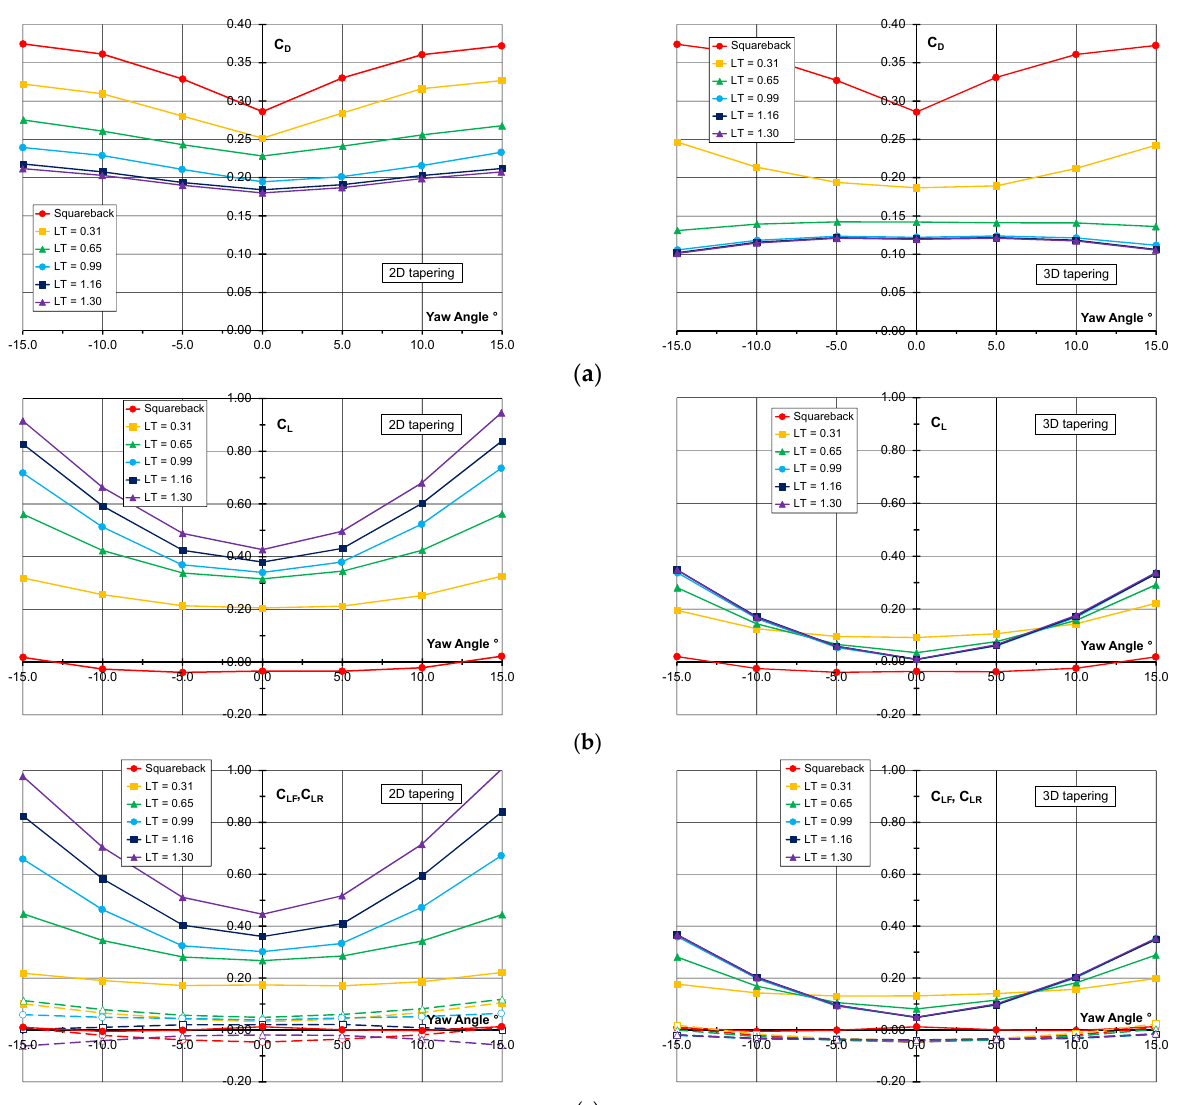
Figure 3. ( a ). Drag coefficient. (Left) 2D tapered body, (Right) 3D tapered body. ( b ). Lift coefficient. (Left) 2D tapered body, (Right) 3D tapered body. ( c ). Front/rear axle lift coefficients. (Left) 2D tapered body, (Right) 3D tapered body. Front, (open symbols, dashed lines), rear, (solid symbols and lines). For the 2D tapered case, the drag coefficient at zero yaw and the drag rise with yaw angle reduce with increasing tail length. The drag rise with yaw reduces with increasing yaw angle. For the 3D tapered bodies the drag at 0 ◦ yaw shows a larger reduction than in the 2D case. The drag variation with yaw is approximately parabolic in form for all the 3D tapered tails. The drag increases with yaw for the shortest tail tested, but reduces with yaw for the longer